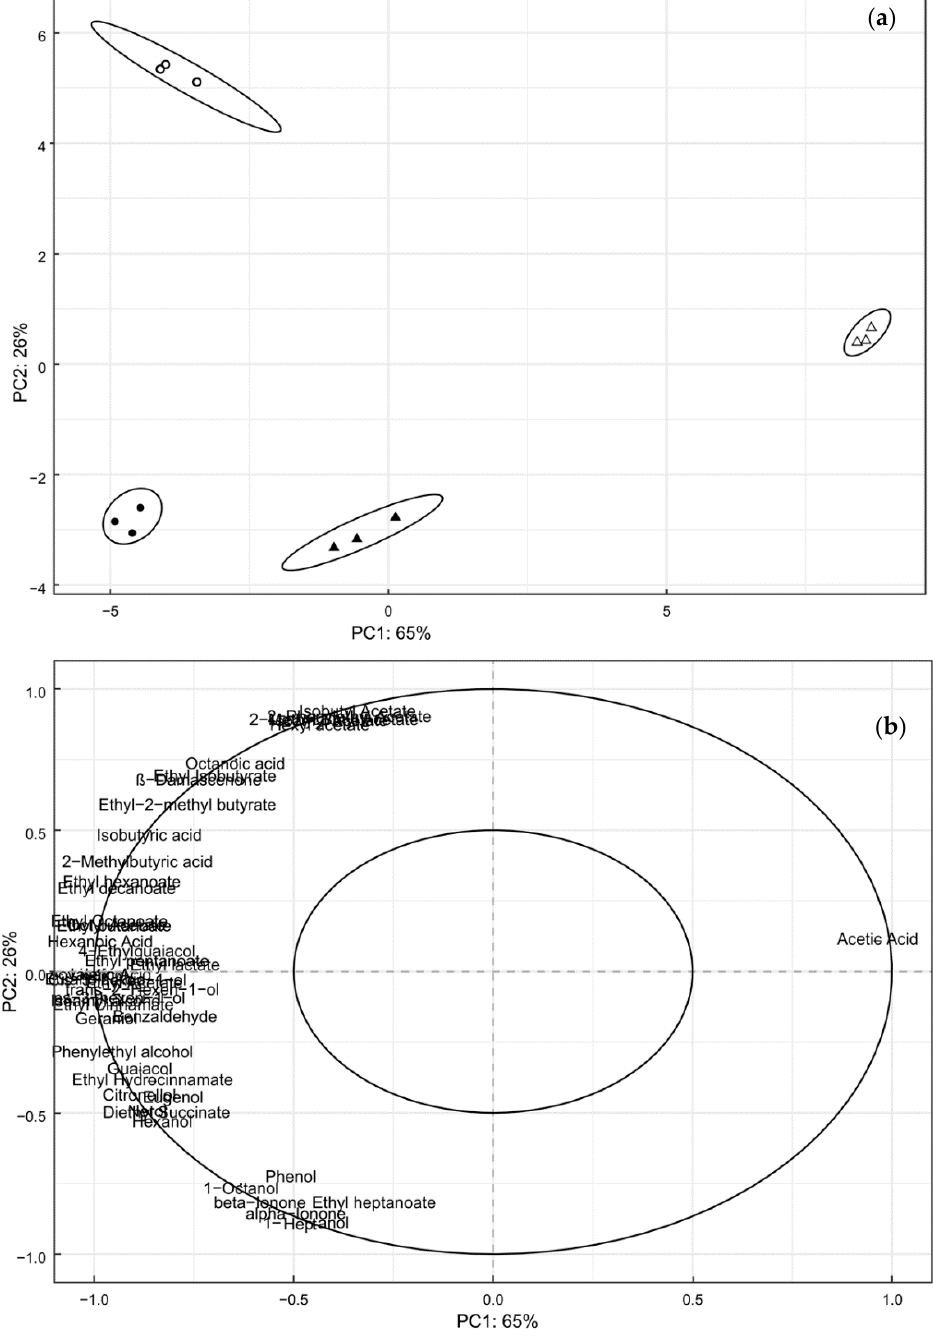
Figure 2. ( a ) Score-plot and ( b ) correlation circle obtained from principal component analysis of aroma compounds determined in wines, GJ-P, grape juice plus pomace ( • ); MJ-P, model juice plus pomace ( (cid:78) ); GJ, grape juice ( ); MJ, model juice ( (cid:52) ).